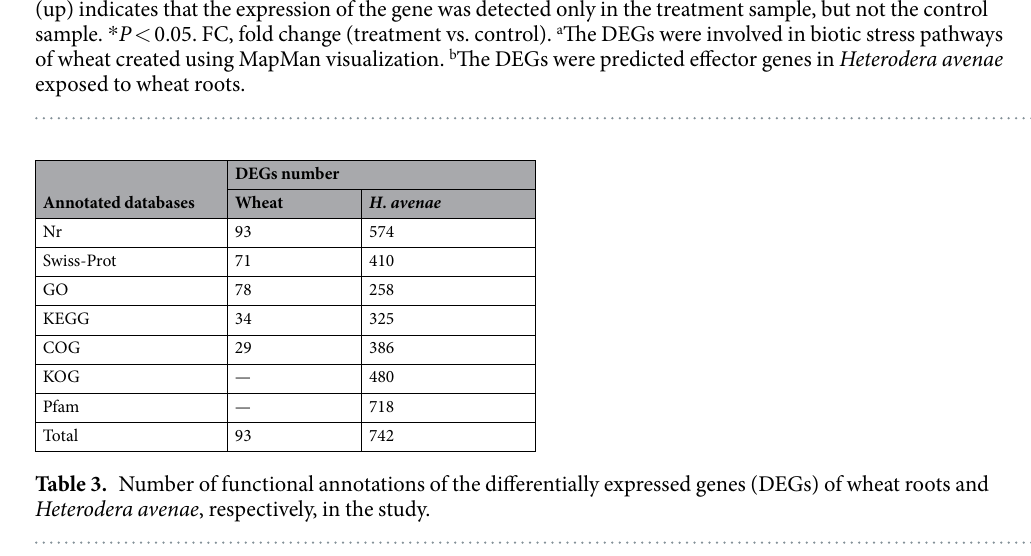
Based on the functional annotation obtained from GO enrichment analysis, the wheat DEGs were separated into 28 functional groups, which belong to three main categories: biological processes (60 DEGs), cellular com- ponents (54 DEGs), and molecular functions (68 DEGs) (Fig. 3a). In the biological process category, greater percentages of DEGs were involved in metabolic processes, single-organism processes and responses to stimuli compared to all unigenes of wheat roots. More proportions of DEGs in the cellular component category were localized to the extracellular region. The DEGs in the molecular function category were more enriched in GO class of nutrient reservoir activity, antioxidant activity, electron carrier activity, enzyme regulator activity and catalytic activity than all unigenes.